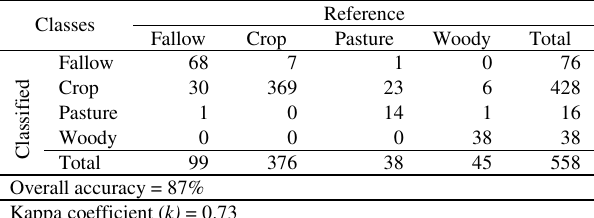
Table 2. Accuracy assessment of summer 2010 classification